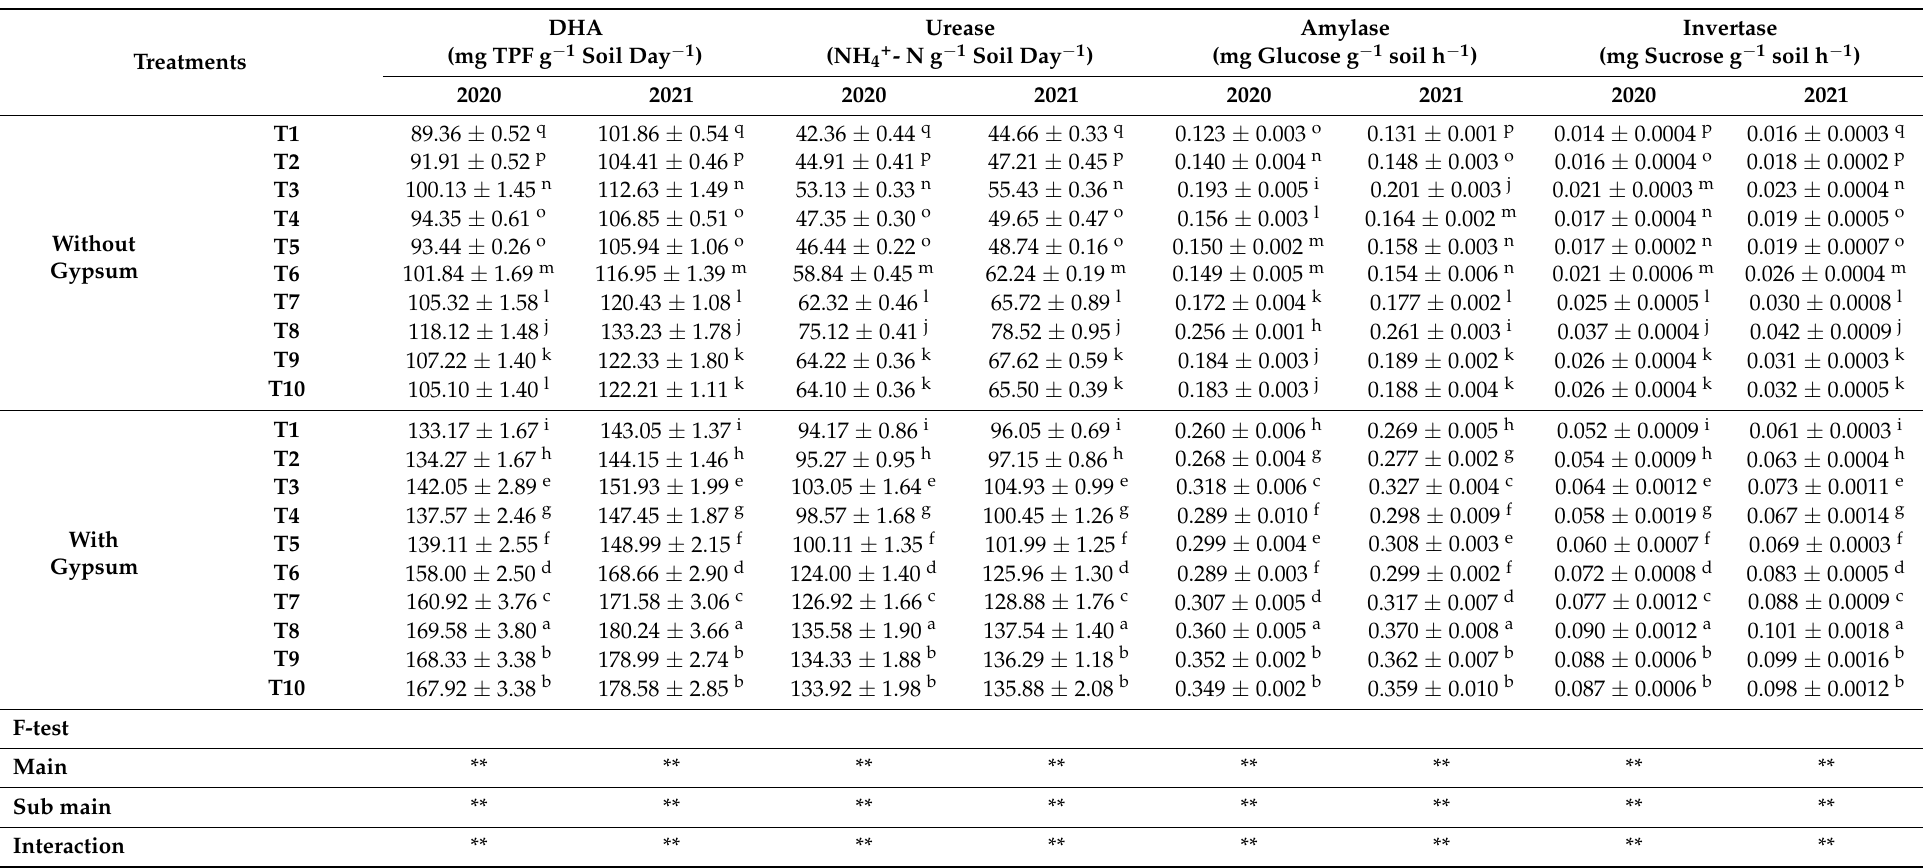
Table 5. Combined effects of gypsum and bio-priming with PGPR and different levels of chitosan (0, 25, 50, 75, and 100 mg L − 1 ), on soil enzyme activities at 60 days from sowing during 2020 and 2021